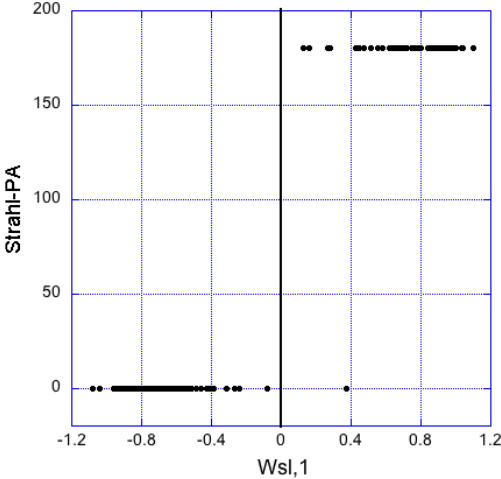
Fig. 12. Scatterplot of the strahl pitch angle and the 1min Wal´en slope for the 173 cases where the strahl pitch angle could be iden- tified. Note the strong correlation, with negative slopes going to- gether with 0 ◦ pitch angles, and positive slopes with 180 ◦ (with one